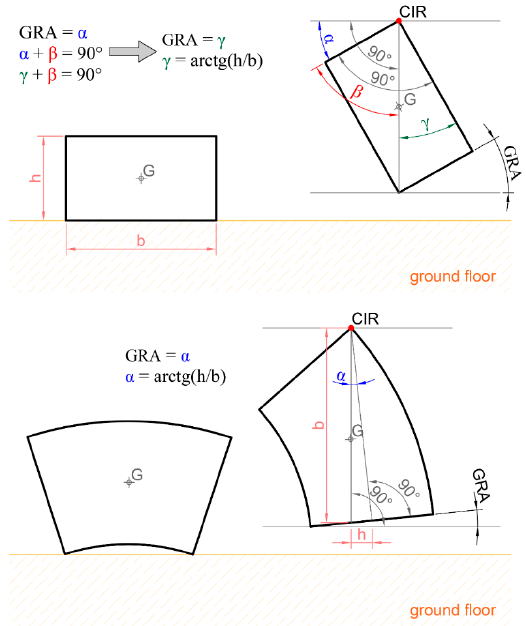
Figure 4. Correlation between the Gravity Rotation Angle (GRA) and the aspect ratio of the block.